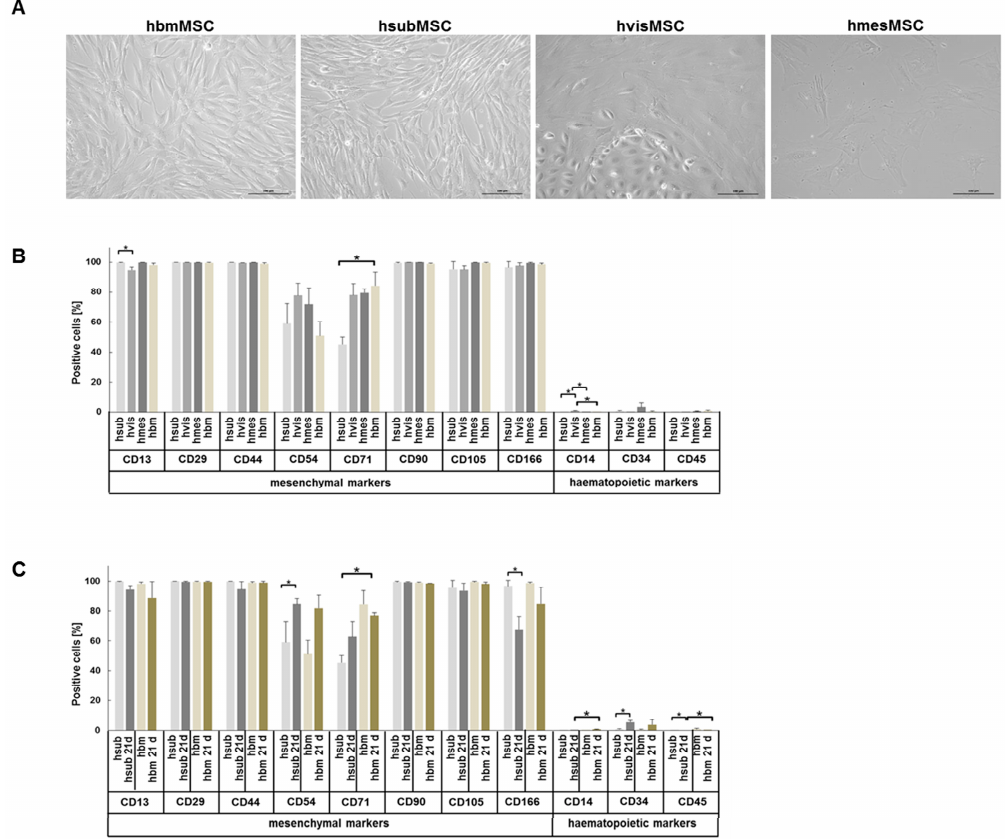
Figure 1. Phenotypic features of mesenchymal stem cells (MSC) from different tissue sources. In ( A ), the morphology of undifferentiated MSC derived from human bone marrow (hbm) and subcutaneous (hsub), visceral (hvis) and mesenteric (hmes) adipose tissue is shown (scale bar: 100 µm). To reach near confluent growth (80%–90%), hbm-, hsub-, and hvis-MSC grew in about 8 days, while hmesMSC needed more than 14 days of culture. (Scale bar: 100 µm); The mesenchymal and hematopoietic surface marker profile ( B ) of undifferentiated MSC derived from subcutaneous (hsub), visceral (hvis), mesenteric (hmes) adipose tissue and bone marrow (hbm) displayed only marginal quantitative differences; After hepatocytic differentiation ( C ) of hsubMSC and hbmMSC, the expression of CD54 increased while that of CD166 decreased significantly (* p < 0.05; mean values from three to five independent analyses using cells from different donors each).